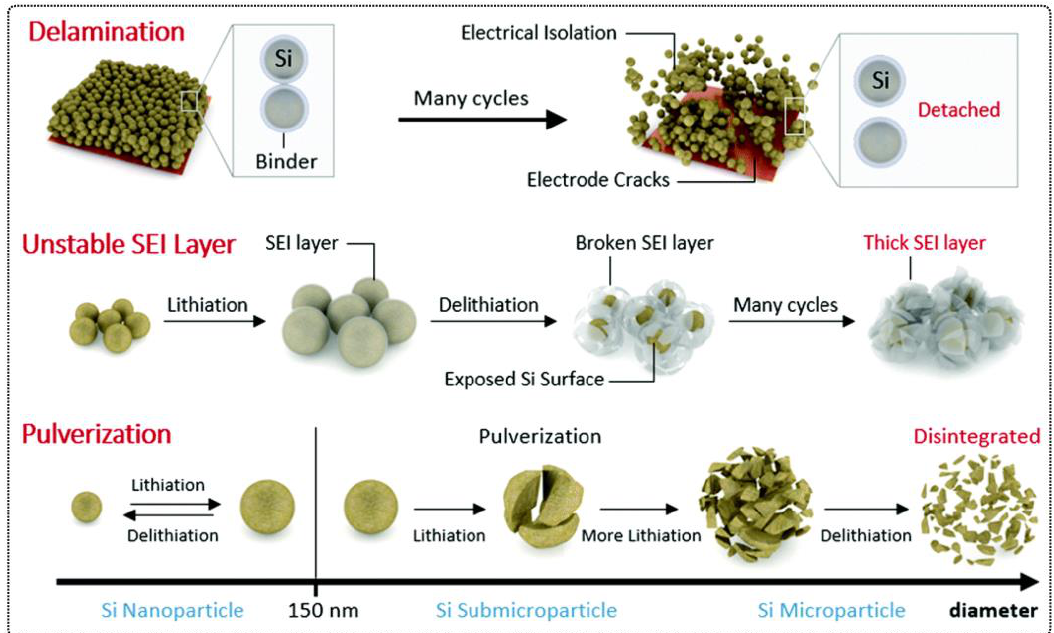
Figure 14. The typical failure mechanisms of Si anodes, including delamination between the different Si particles and current collector, the formation of an unstable SEI layer and the pulverization of Si microparticles. Reproduced from [159] with permission from the Royal Society of Chemistry.